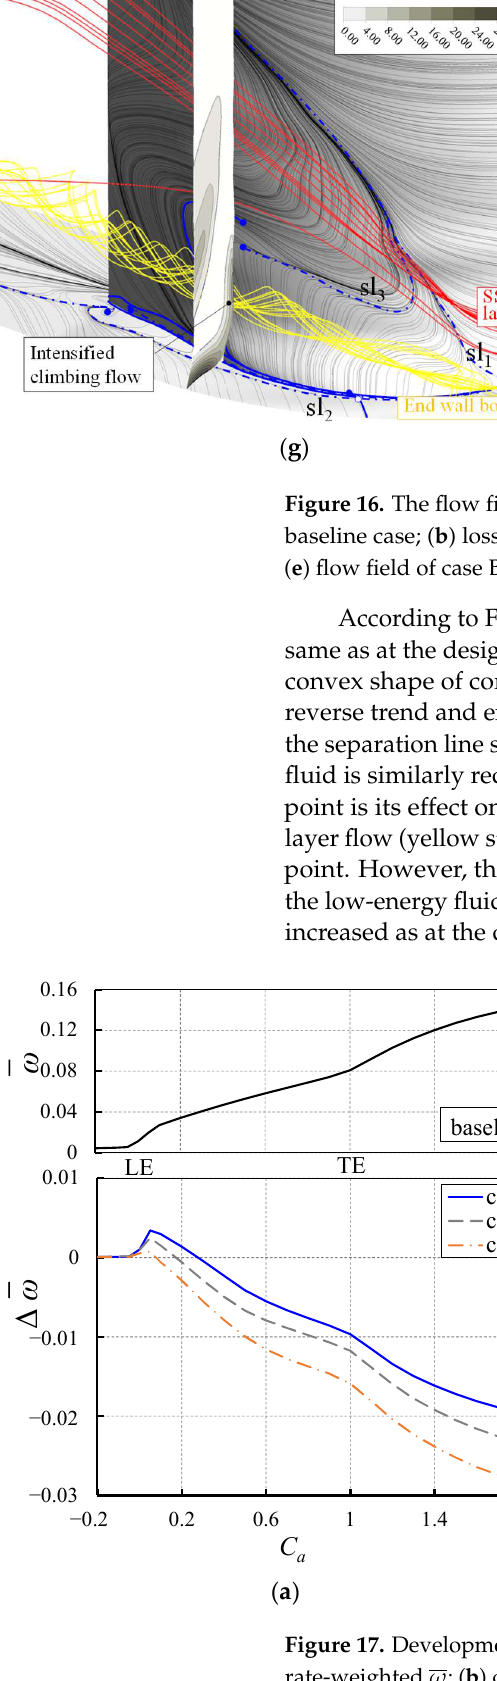
Figure 17. Development of loss in the passage at the near-stall point. ( a ) Development of mass-flow- rate-weighted ω ; ( b ) development of area-averaged Φ